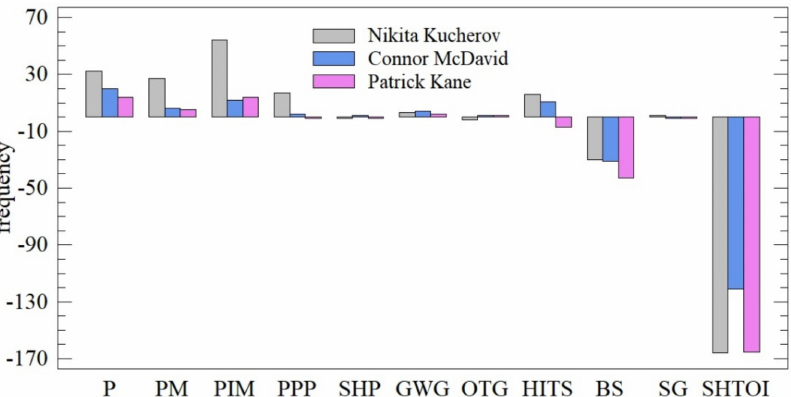
Figure 8. Comparison with the best player as evaluated by the CRITIC–TOPSIS combination (Alek- sander